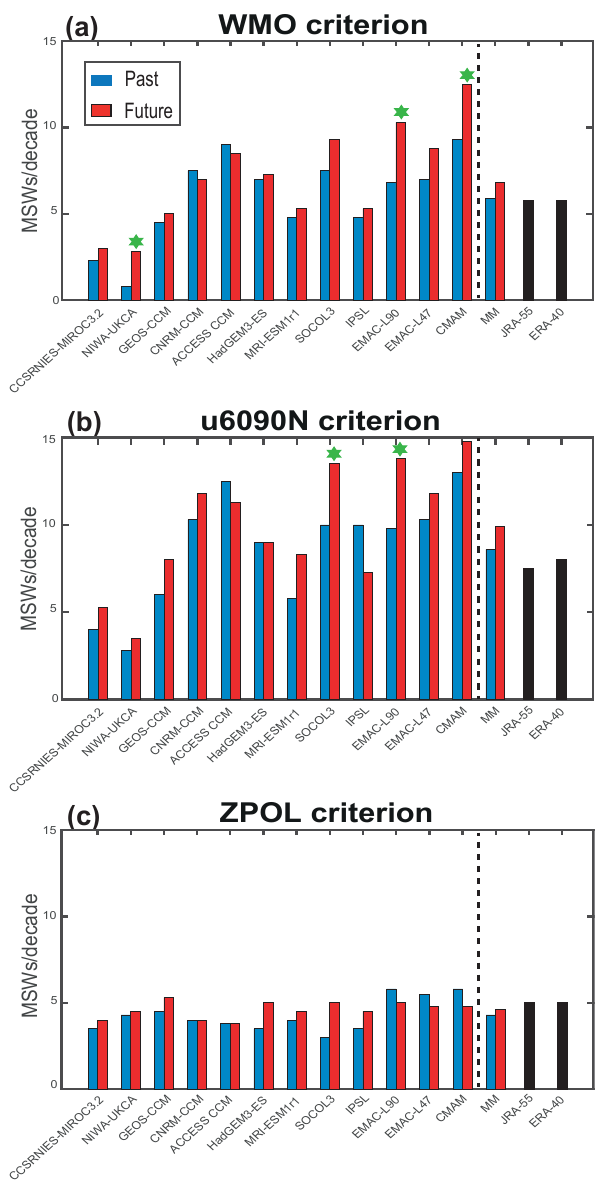
Figure 1. (a) Mean frequency of stratospheric sudden warmings per decade for the past (blue bars) and the future (red bars) for all models, the multi-model mean (MM), and JRA-55 and ERA-40 re- analyses (black bars) according to the WMO criterion. (b, c) Same as (a) but for the u6090N and ZPOL, respectively. Green stars on top of the future bar denote a statistically significant change in the frequency of SSWs in the future at the 95% confidence